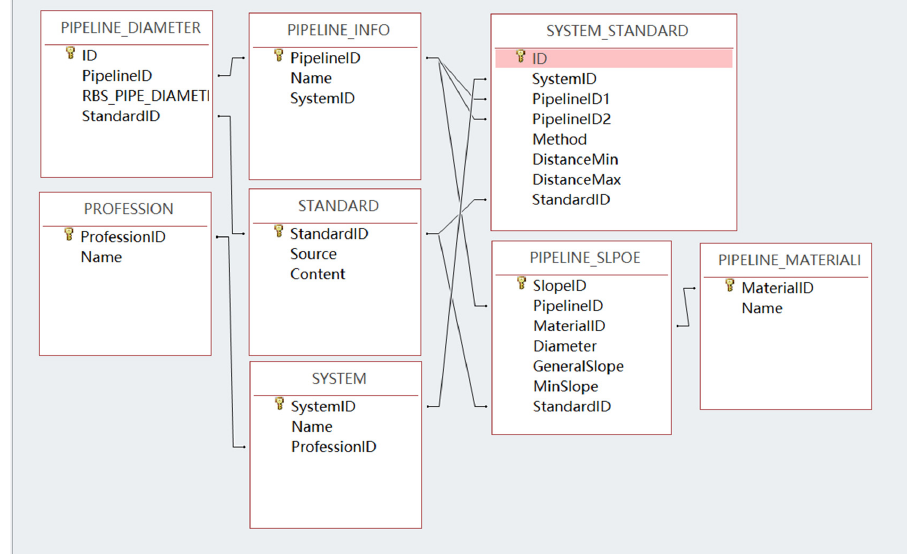
Figure 5. Relationship among the tables of the MEP knowledge base.